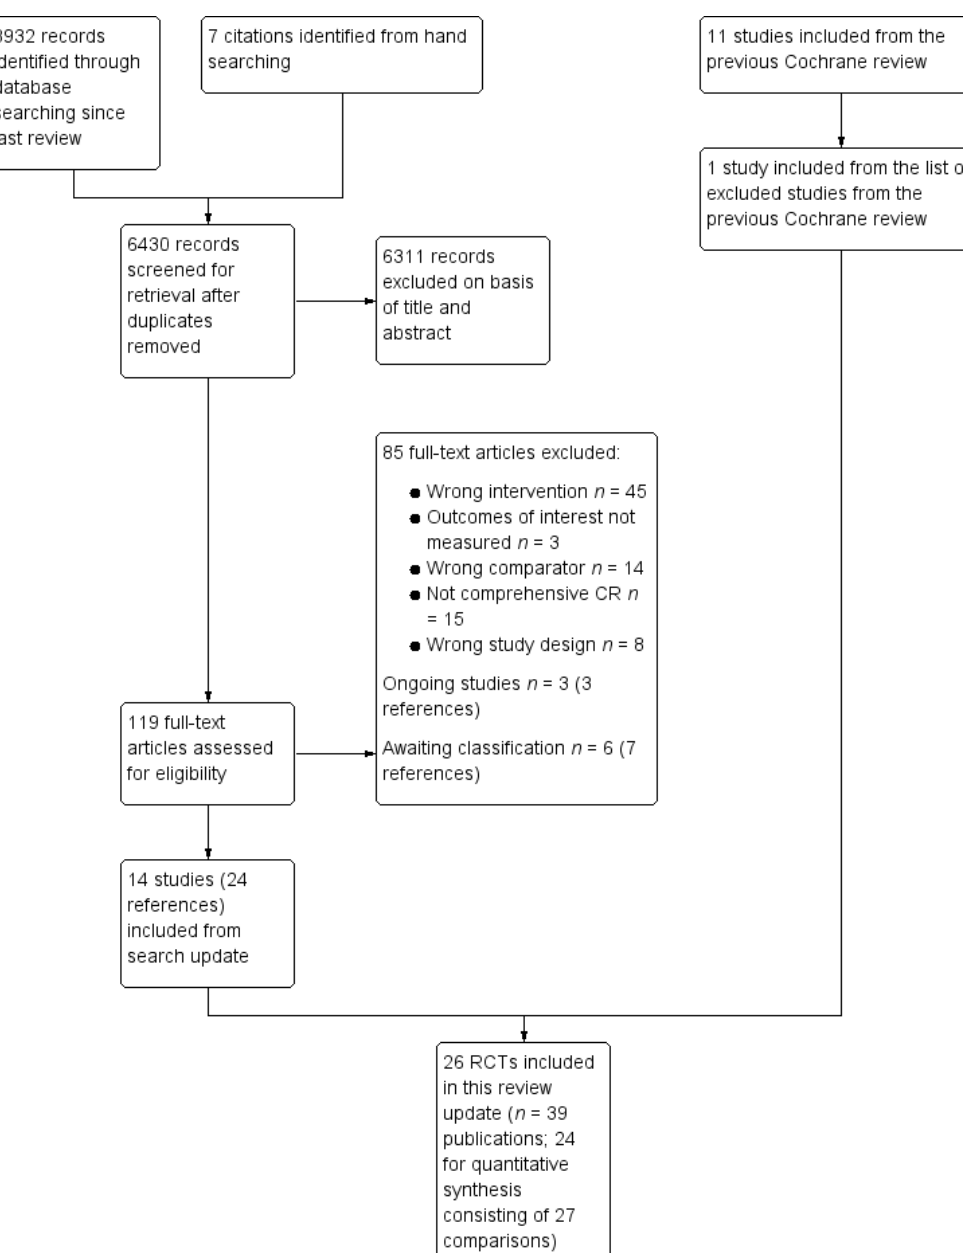
Figure 1. Summary of the study selection process. CR—cardiac rehabilitation; RCTs—randomized or quasi-randomized controlled trials.